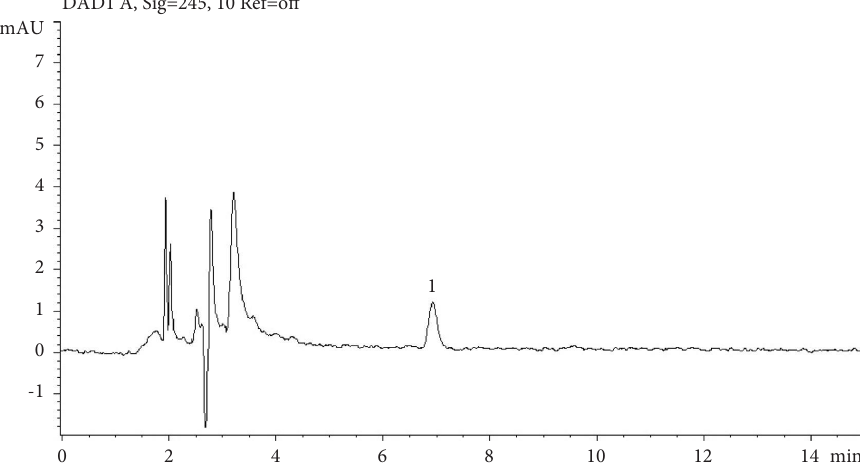
Figure 1: Chromatogram of a blank sample. At ivermectin retention times, no peak was registered, while doramectin’s peak is indicated with number 1 (RT